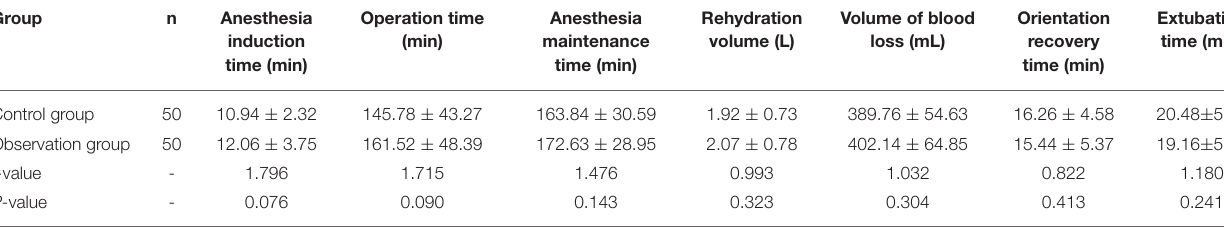
TABLE 2 | Comparison of surgical conditions between the two groups ( ¯ x ±